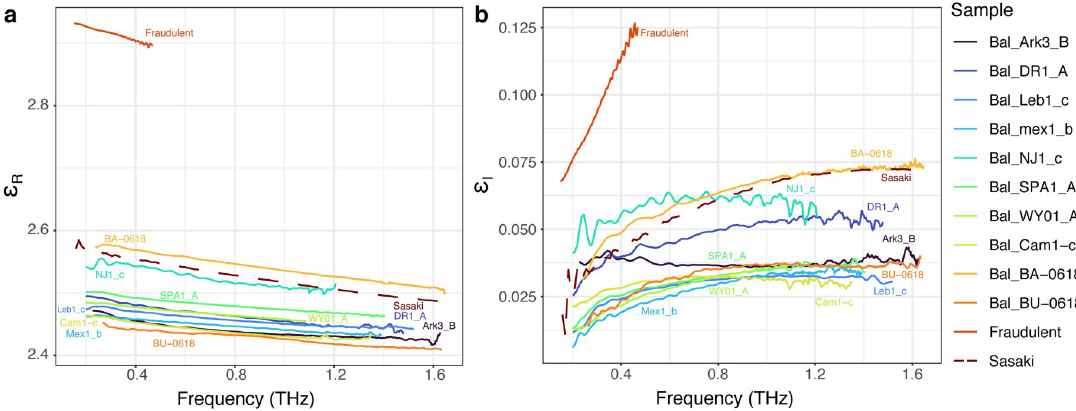
Fig 6. Evaluation of fraudulent synthetic amber relative to amber samples. Extracted real (a) and imaginary (b) permittivity from selected clear amber samples. The previous Baltic Amber results of Sasaki et al. [28] are shown as a dashed line for comparison. The Sasaki et al. [28] data are in close agreement with the spectral response of Baltic Amber measured in the present